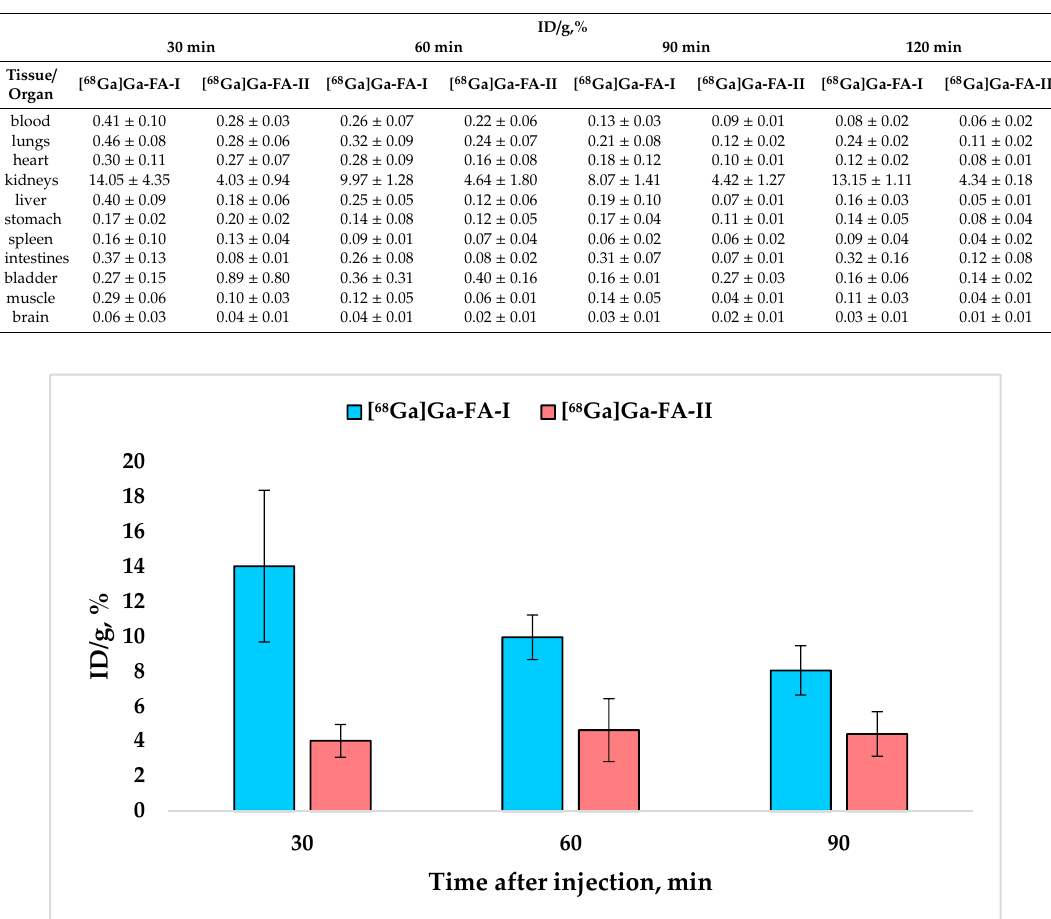
Table 1. Biodistribution of [ 68 Ga] Ga-FA-I and [ 68 Ga] Ga-FA-II in normal Wistar rats ( mean ± SD, n = 5 ).